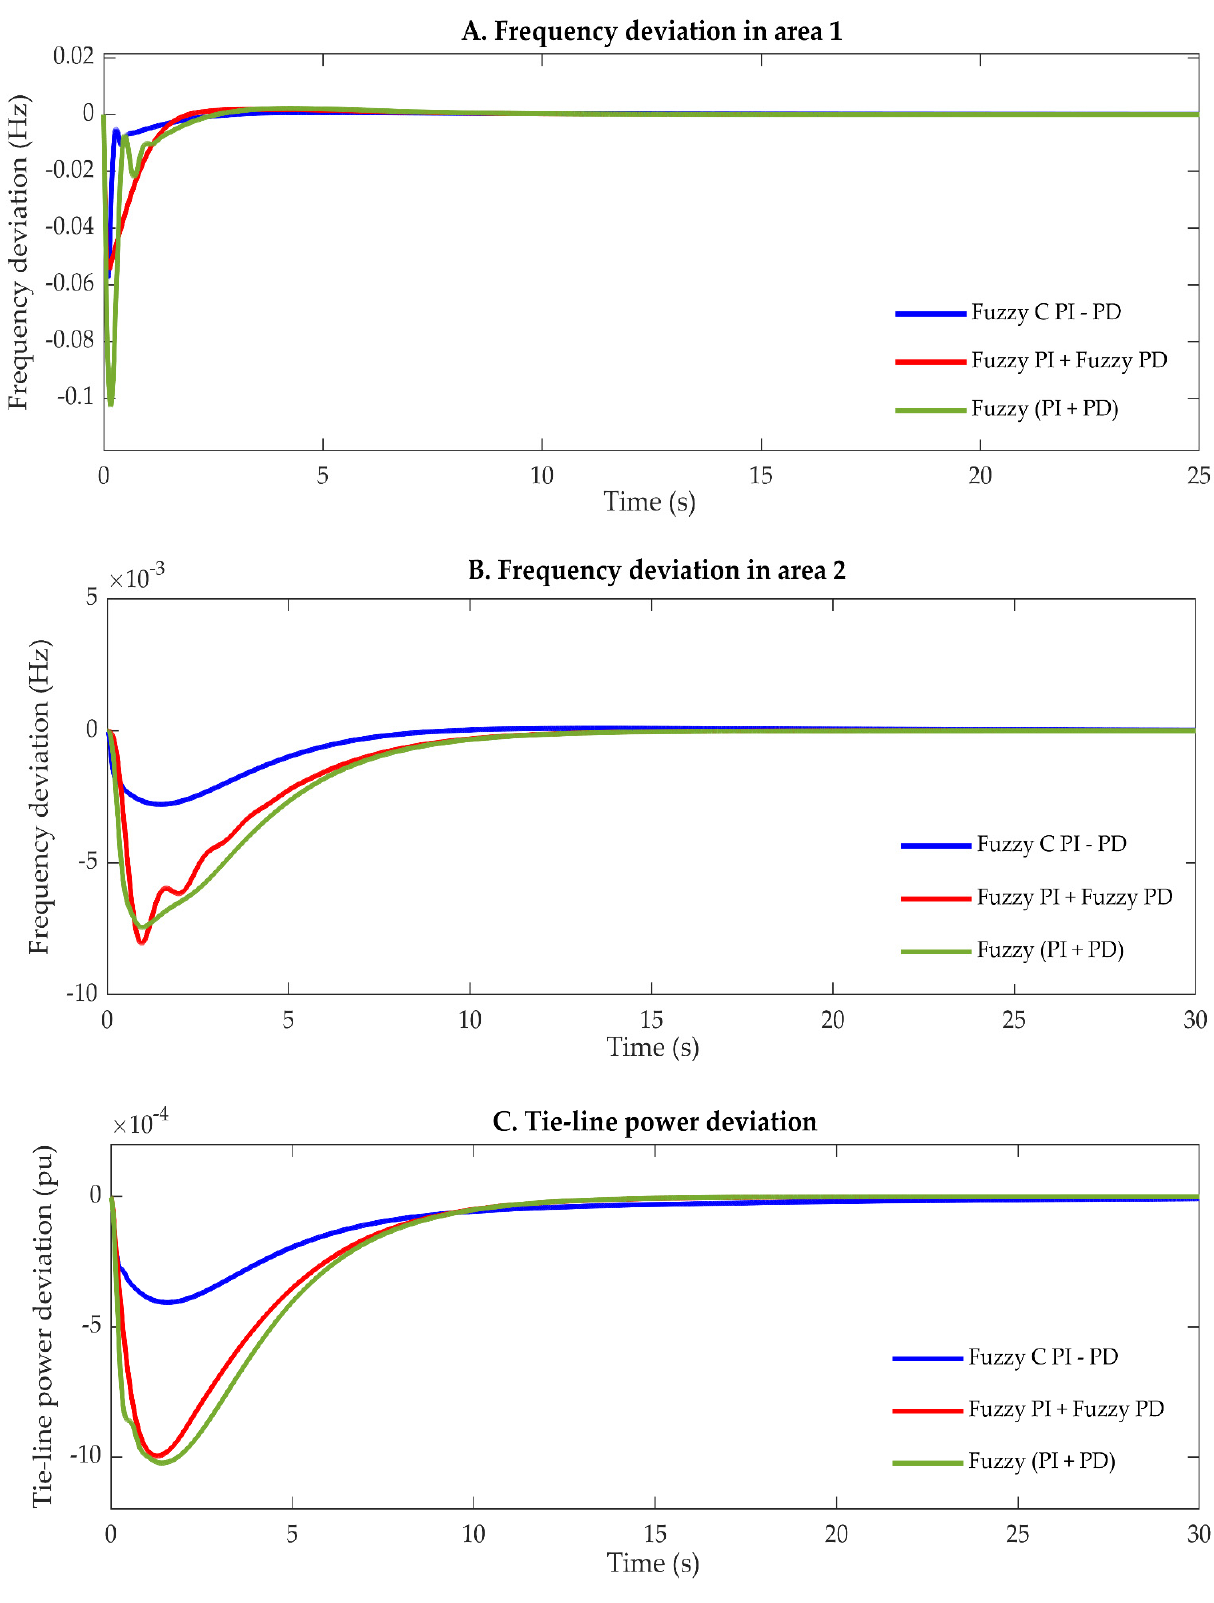
Figure 27. Dynamic response of the testbed power system based on different fuzzy controllers under parametric uncertainty conditions, case 6. ( A ) Frequency variation in area 1; ( B ) frequency variation in area 2; ( C ) tie-line power variation.